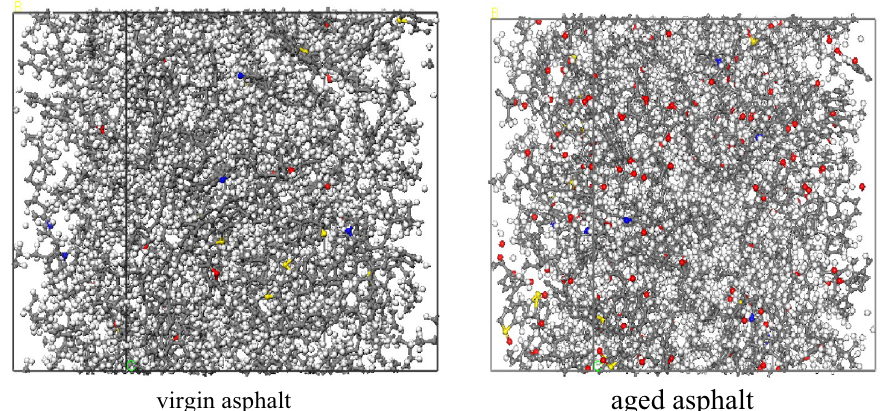
virgin asphalt aged asphalt Figure 1. The virgin asphalt and aged asphalt MD models.